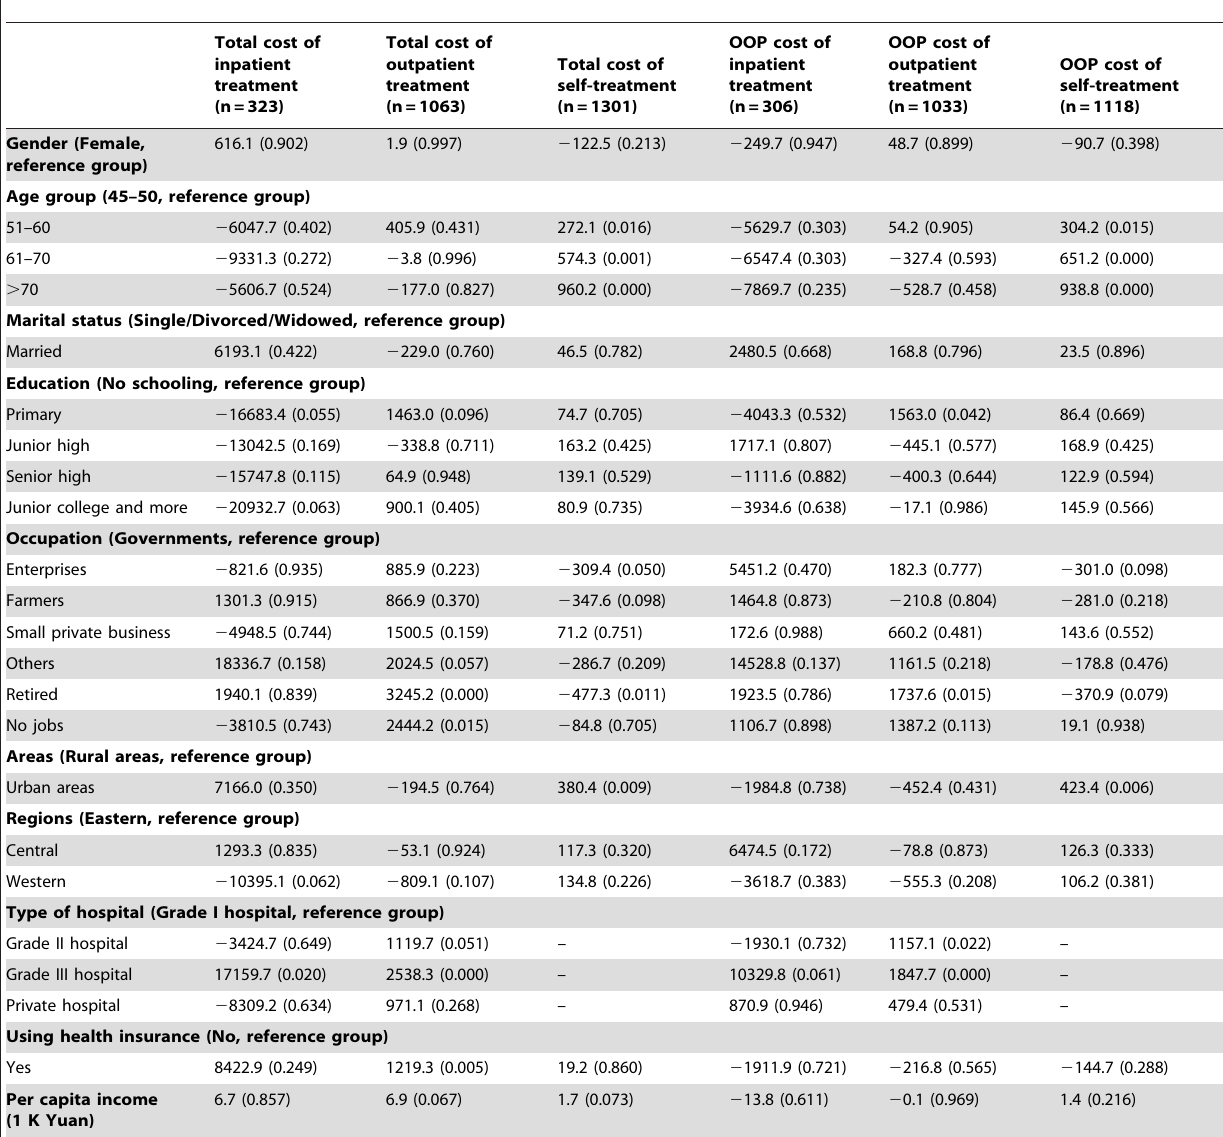
Table 4. Multivariate analysis of medical